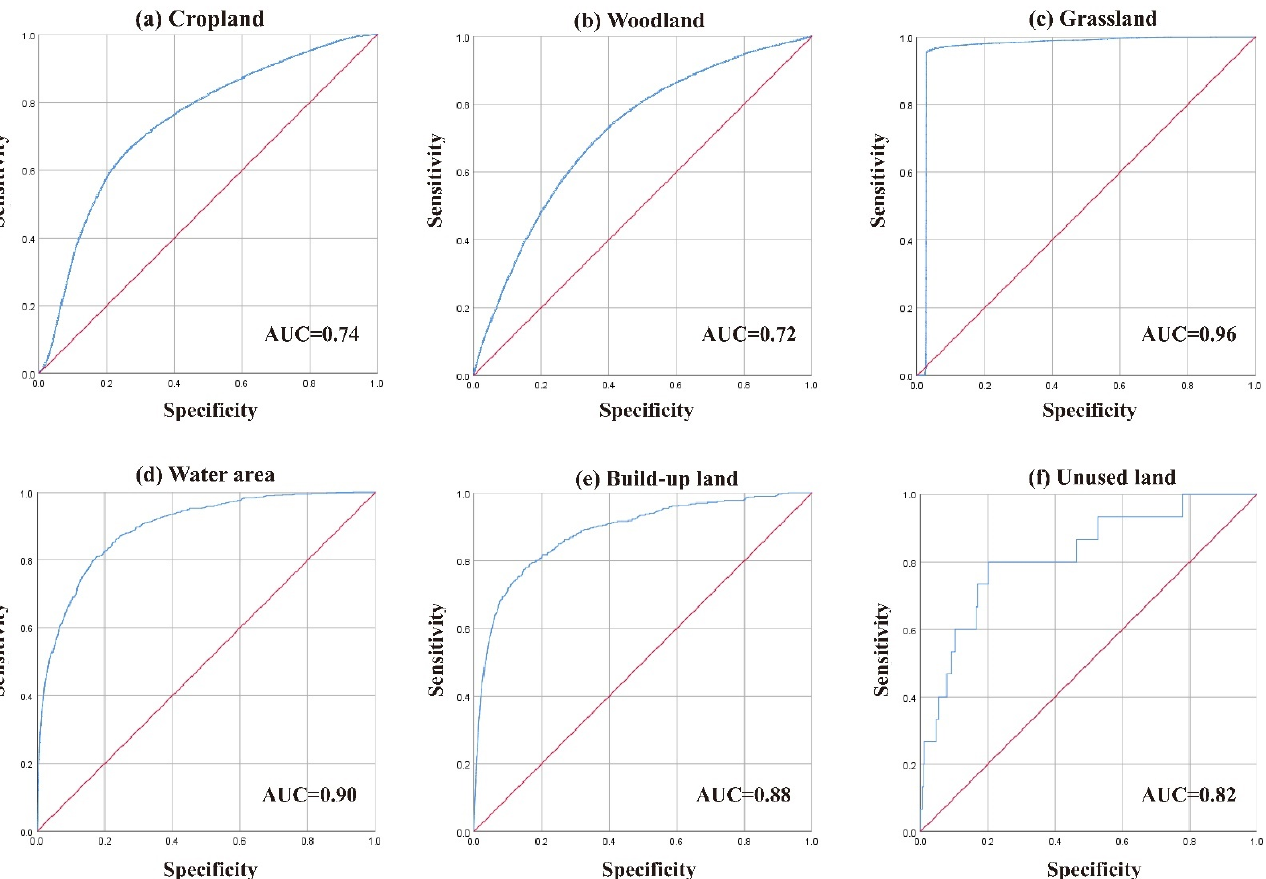
Figure A1. ROC curves and AUC values for each land use type. ( a ) Cropland, ( b ) Woodland, ( c ) Grassland, ( d ) Water area, ( e ) Built-up land, ( f ) Unused land.